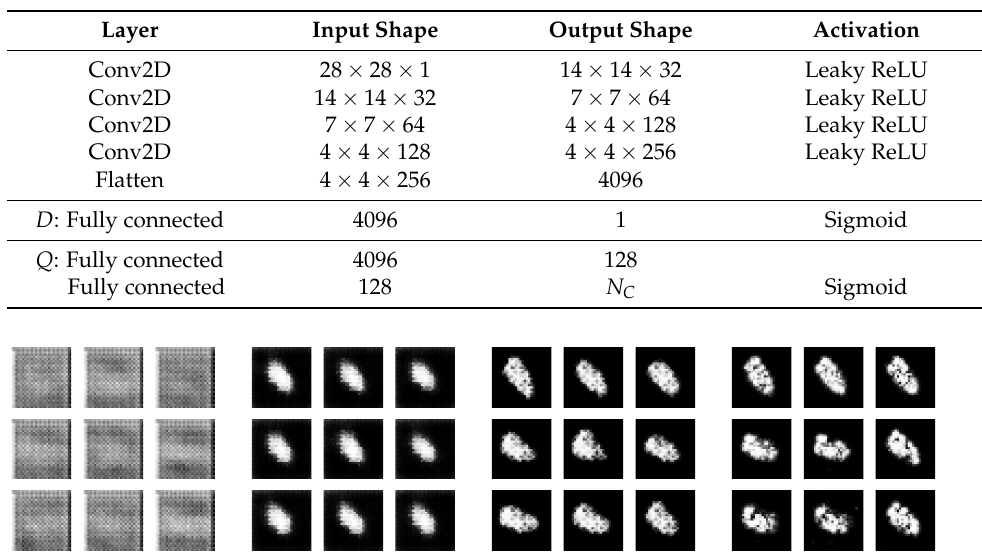
Table 4. The architecture of the discriminator D and the classifier, Q .